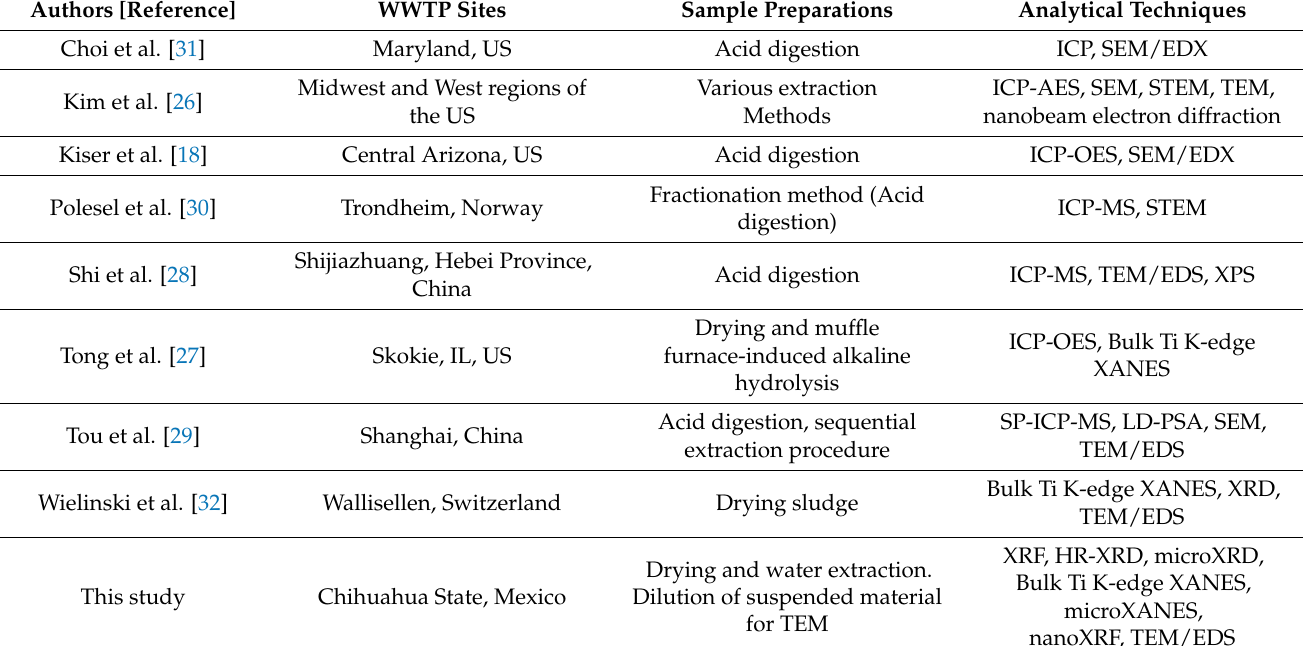
Table A1. Analytic techniques of the previous and present WWTP sludge TiO 2 characterization